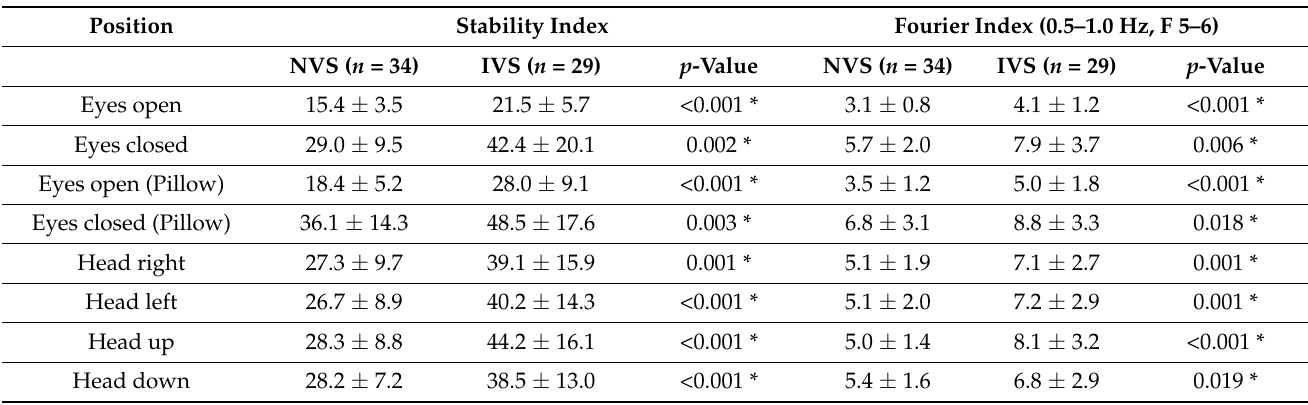
Table 3. Stability index and Fourier indices in eight positions in patients with DM with NVS vs. IVS according to VPT value. Position